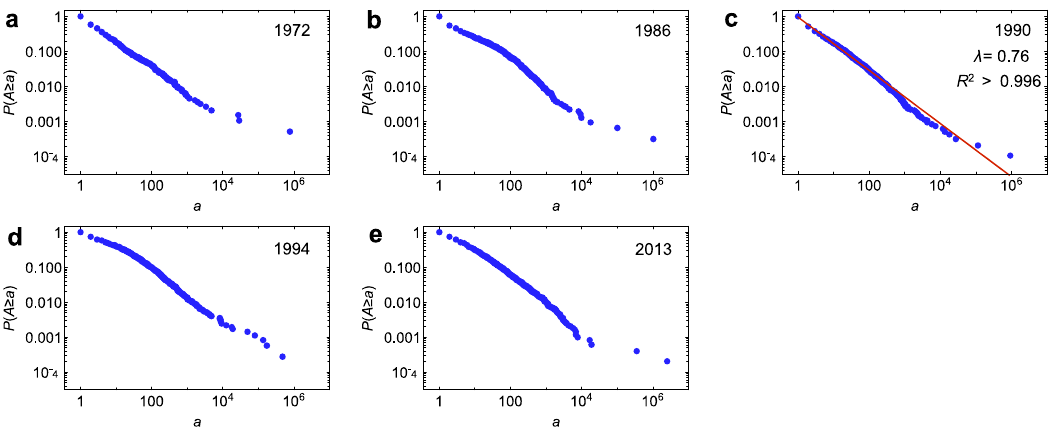
Fig. 3 The observed size distribution of woody patches on Hog Island based on imagery data. The size distributions were shown for the following years: 1972 ( a ), 1986 ( b ), 1990 ( c ), 1994 ( d ) and 2013 ( e ). The size distribution follows a power law in